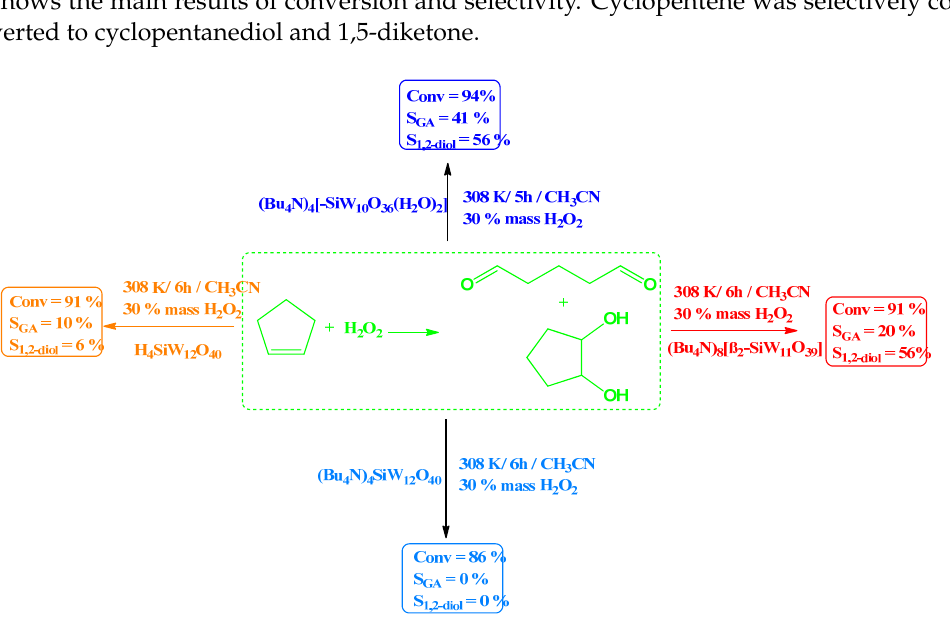
Scheme 15. Conversion and selectivity of silicotungstate-catalyzed oxidation of cyclopentene with hydrogen peroxide (adapted from ref. [45]) a,b . a Reaction conditions, catalyst (0.03 mmol), CH 3 CN (4 mL), cyclopentene (25 mmol), H 2 O 2 (30% (mass)) 30 mmol); stirring speed: 500 r·min − 1 . b